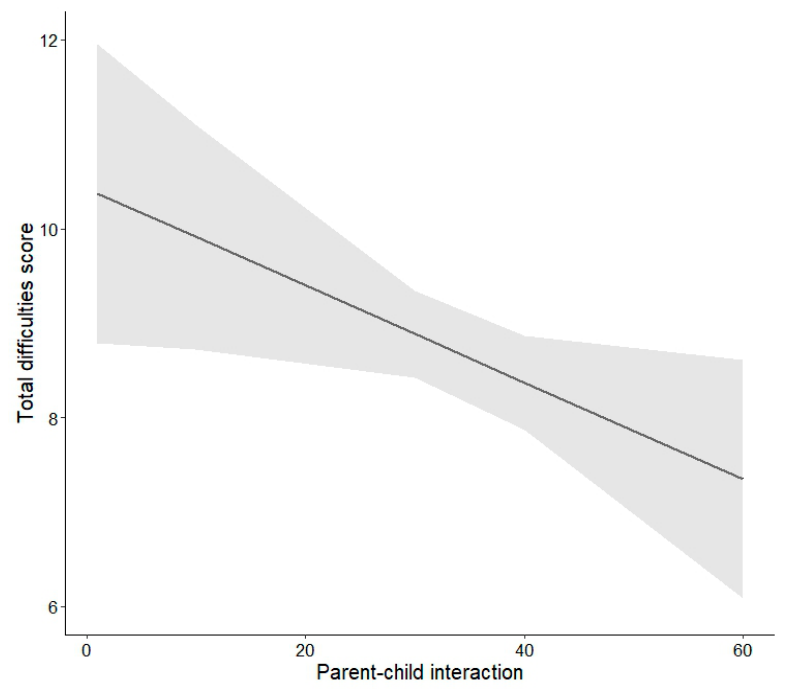
Figure 2. Effect plot (mean effect and 95% CI) illustrating the estimated total behavioral difficulties scores of children depending on parent–child interaction